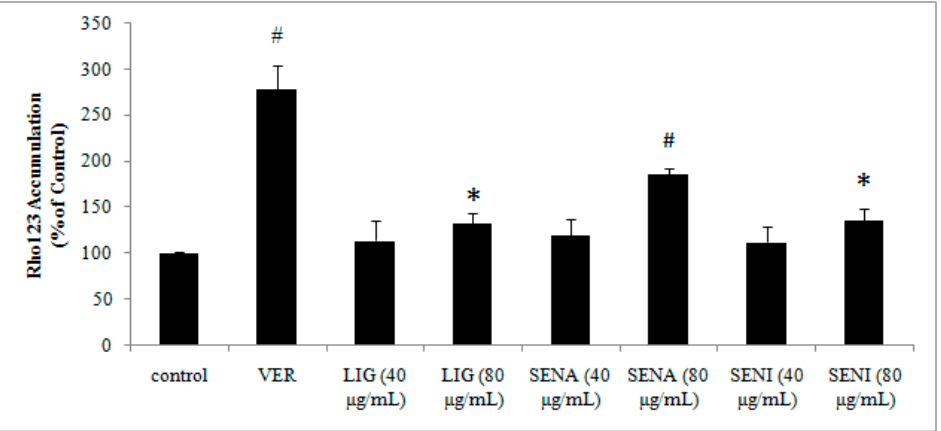
Figure 6. Effects of Ver, LIG, SENA and SENI on P-gp-mediated efflux function in MDCK-MDR1. Values are mean ± SD ( n = 3). Differs from control group: * p < 0.05, # p < 0.01.